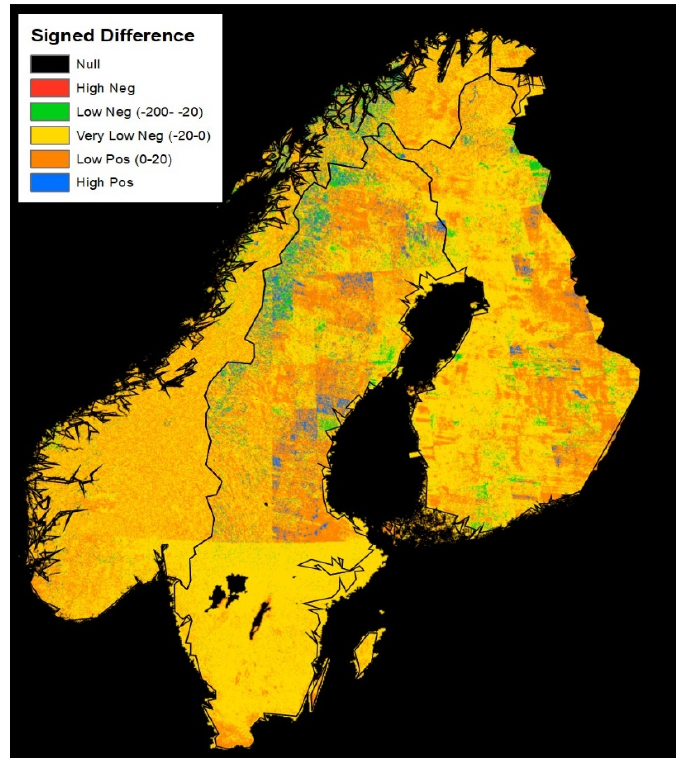
Figure 10. Sweden, Norway and Finland (SNF) minus Collection-1 DEM difference image.